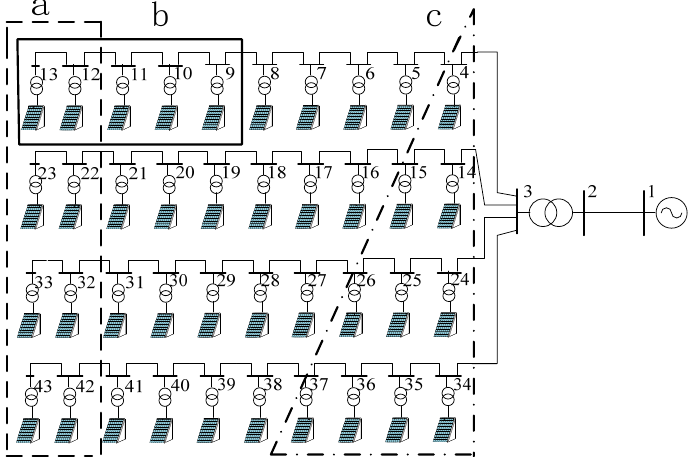
Figure 4. Diagram of the centralized PV cluster simulation system. Table 1. The parameter of the line.